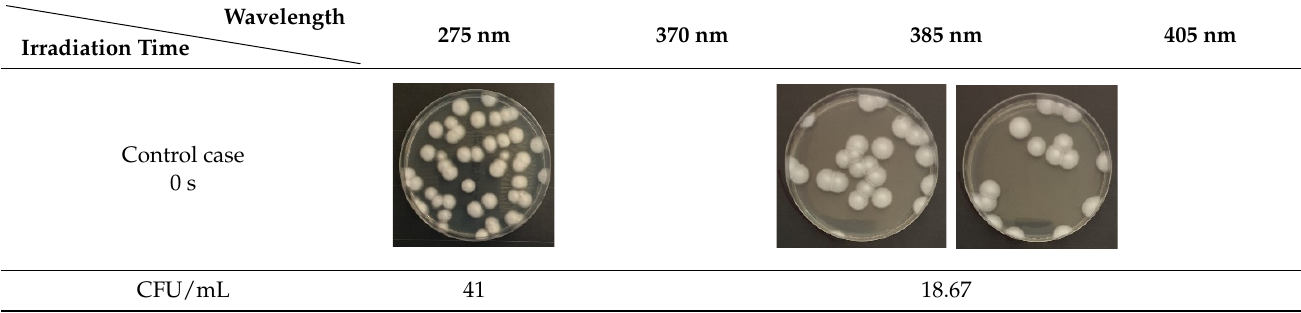
Table 5. Numbers of E. coli colonies by wavelength and irradiation time.